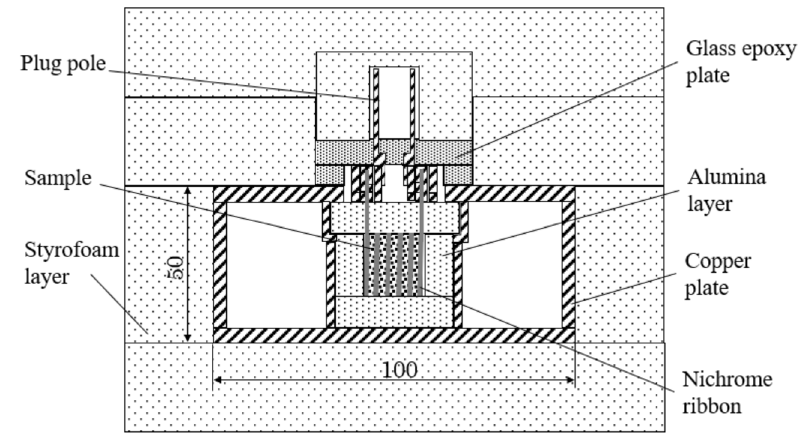
Figure 1: A schematic diagram of the adiabatic